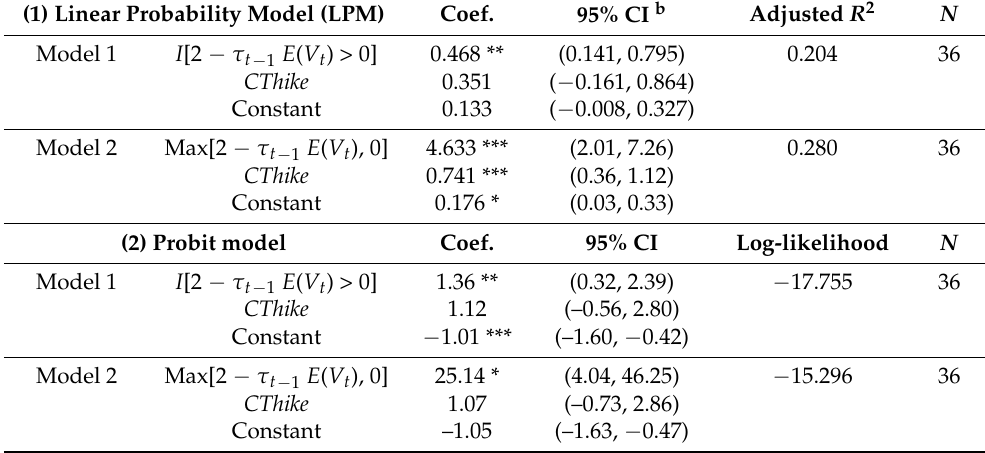
Table 1. Estimation results of models to explain the probability of a cigarette tax increase a . (1) Linear Probability Model (LPM)